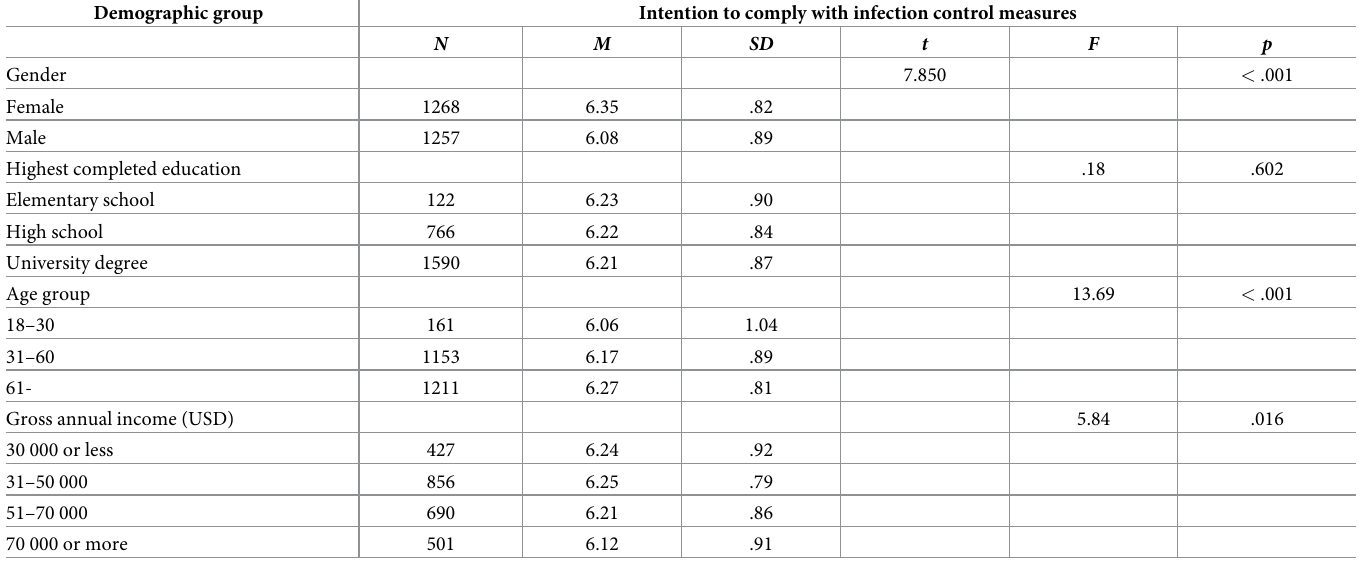
Table 2. Intention to comply with infection control measures by demographic